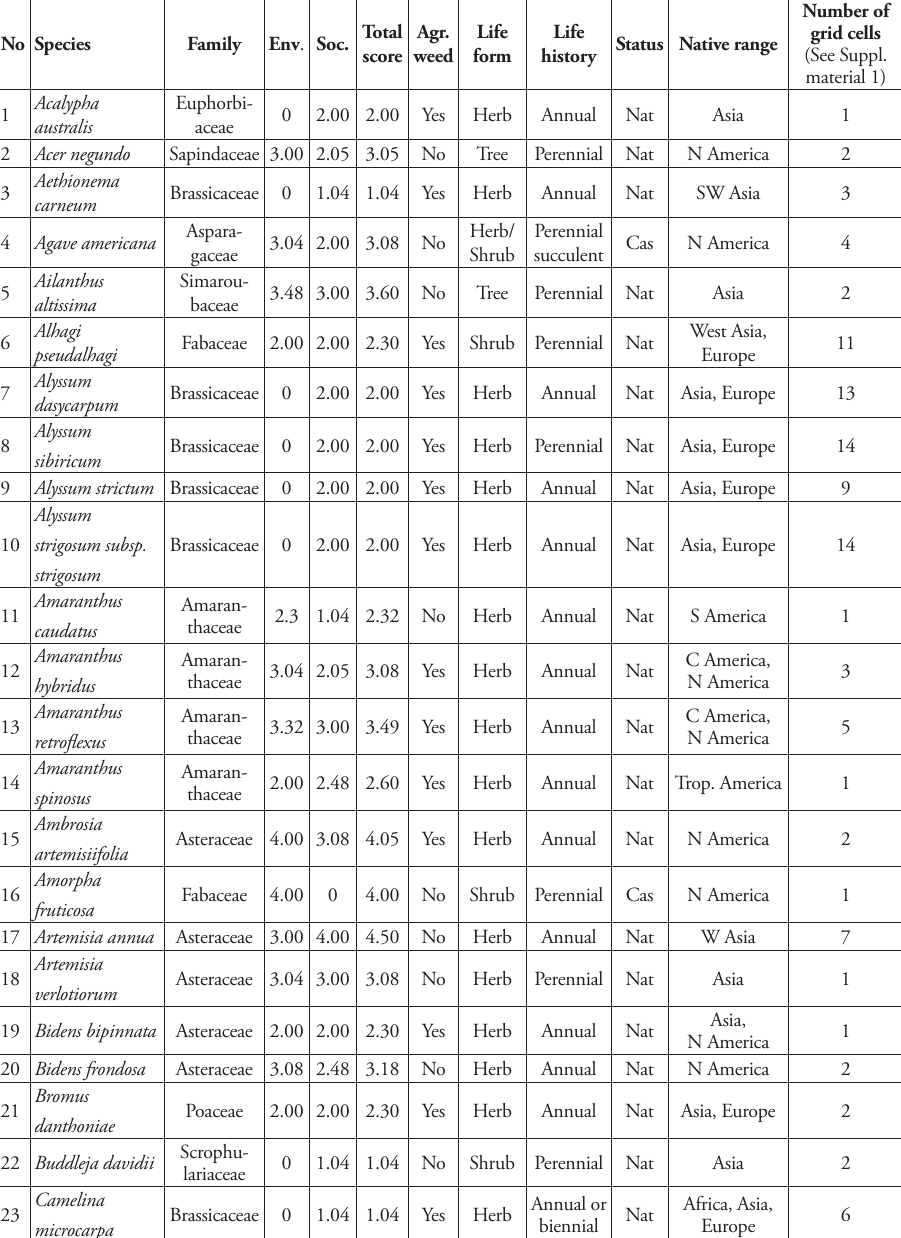
Table 1. Environmental (Env.), socioeconomic (Soc.) and total (logarithmic sum; see text for explanation) impacts of alien species in Turkey. Each taxon is listed with its family, life form, life history, invasion status in Turkey (Cas = casual, Nat = naturalized; Pyšek et al. 2004, Blackburn et al. 2011), native range and distribu- tion extent in Turkey. Status as an agricultural weed, based on literature, is indicated (see text for details). No Species Family Env . Soc.